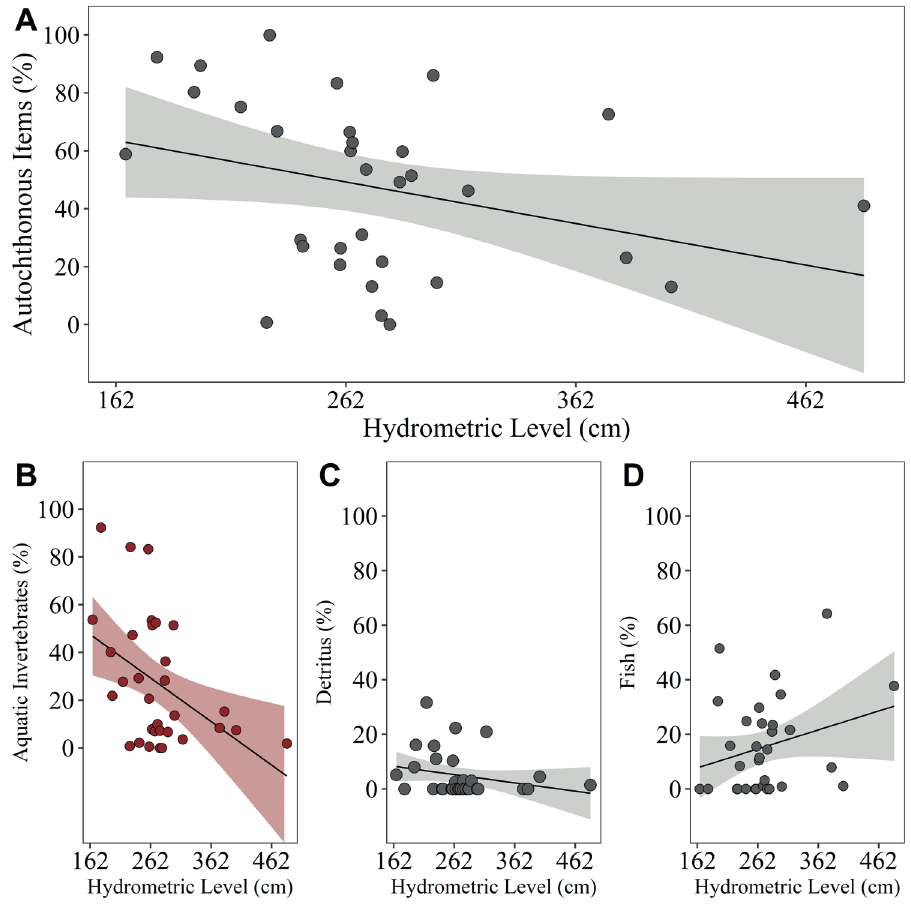
FIGURE 4 | A. Relationship between the hydrometric level and the consumption of all autochthonous items; B. The consumption of aquatic invertebrates; C. The consumption of detritus; D. And the consumption of fish for Trachelyopterus galeatus. Red graphs indicate a significant negative influence of the variable as a function of hydrometric level, while grayscale graphs indicate a non-significance.